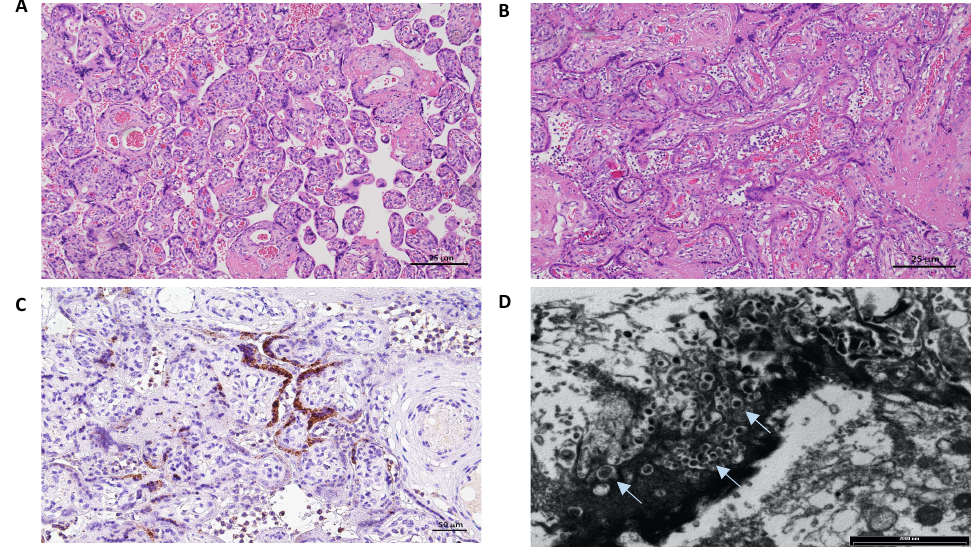
Figure 2. Placental pathology findings of the two cases . The Placenta of case 1 weighed 246 g and measured 13 × 12 × 4 cm; the umbilical cord appeared hypercoiled (5 coils per 10 cm) and was 13 cm long with a diameter between 0.9–1.5 cm. No gross anomalies were observed. ( A ) Hematoxilin and Eosin staining (4HPF): mild subchorionitis with normally developed parenchyma for gestational age. The Placenta of case 2 weighed 347 g and measured 18 × 13 × 3 cm; the umbilical cord had 2 coils every 10 cm and was 27 cm long with a diameter between 1–1.5 cm. Macroscopically, it appeared pale. ( B ) Hematoxilin and Eosin staining (4HPF): diffuse intervillous fibrinoid deposition with intervillositis mainly represented by lymphocytes, histiocytes and few granulocytes. ( C ) Immunostaining for SARS-CoV-2 nucleocapsid protein (polyclonal, Novus biological, USA) (10HPF): diffuse positivity in the syncytiotrophoblast. Lymphocyte immunohistochemical characterization (not shown) revealed a prevalence population of TCD4, and few activated TCD8 evidenced by Granzyme B staining. ( D ) Electron microscopy examination: many viral particles (arrows) in the cytoplasm of the